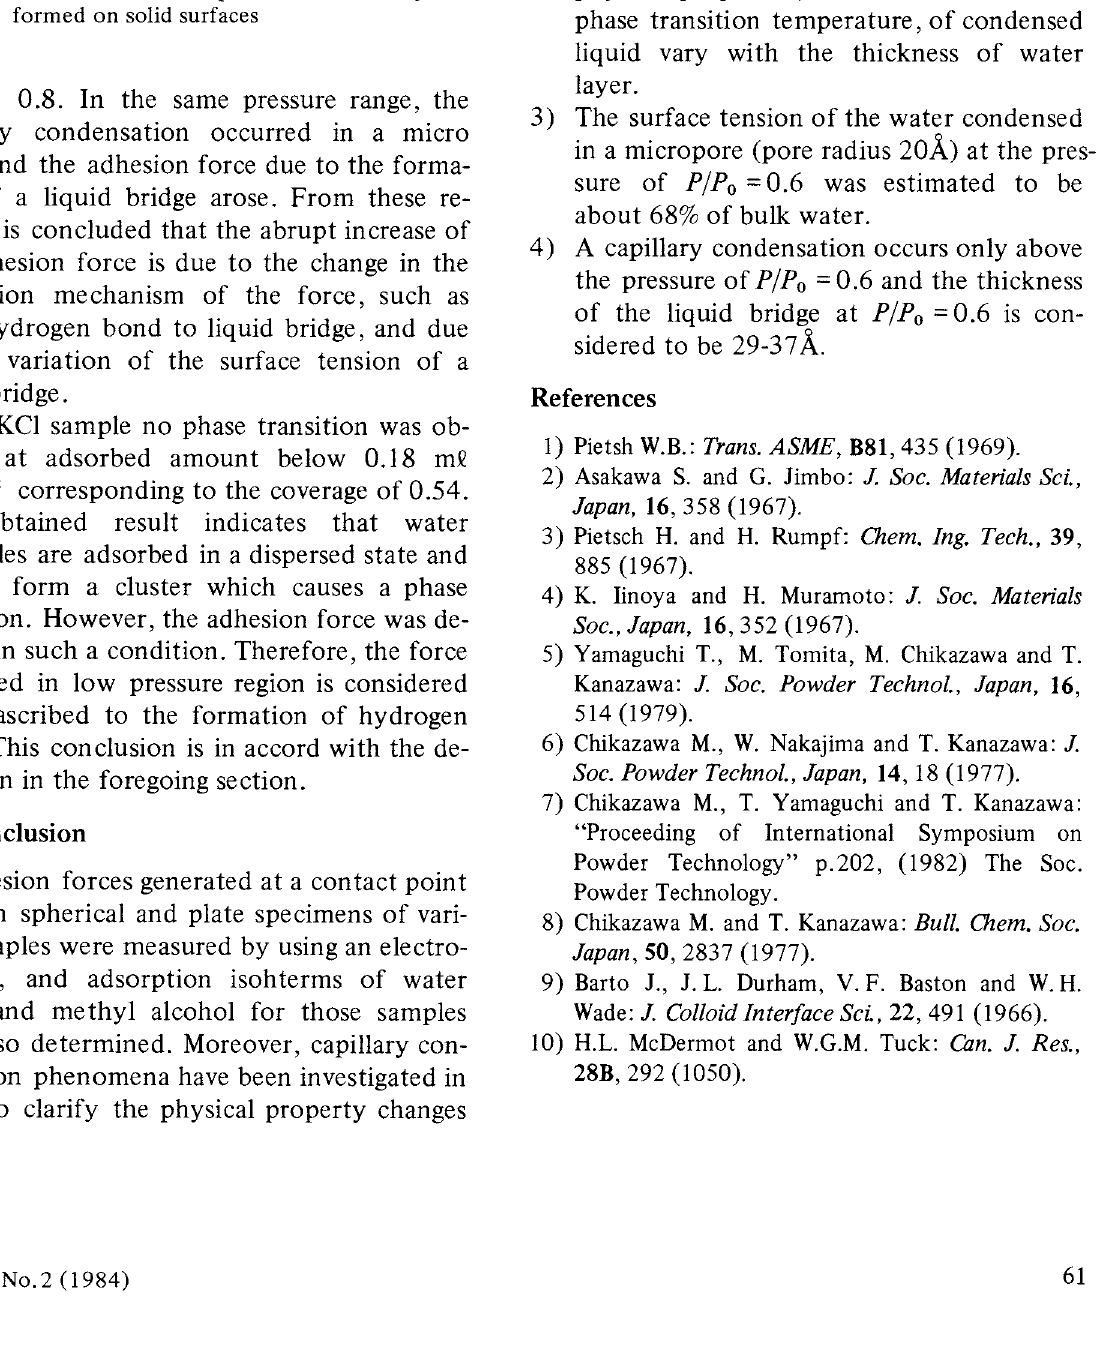
Fig. 11 Phase transition temperature of water layer formed on solid